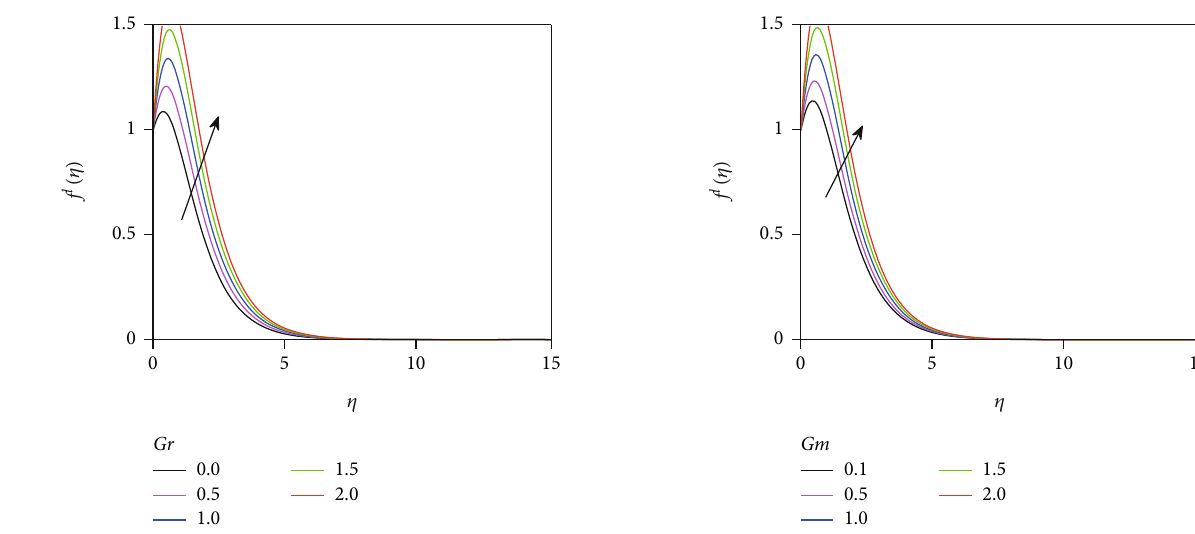
Figure 11: Signi fi cance of the mass Grashof number on velocity plot.